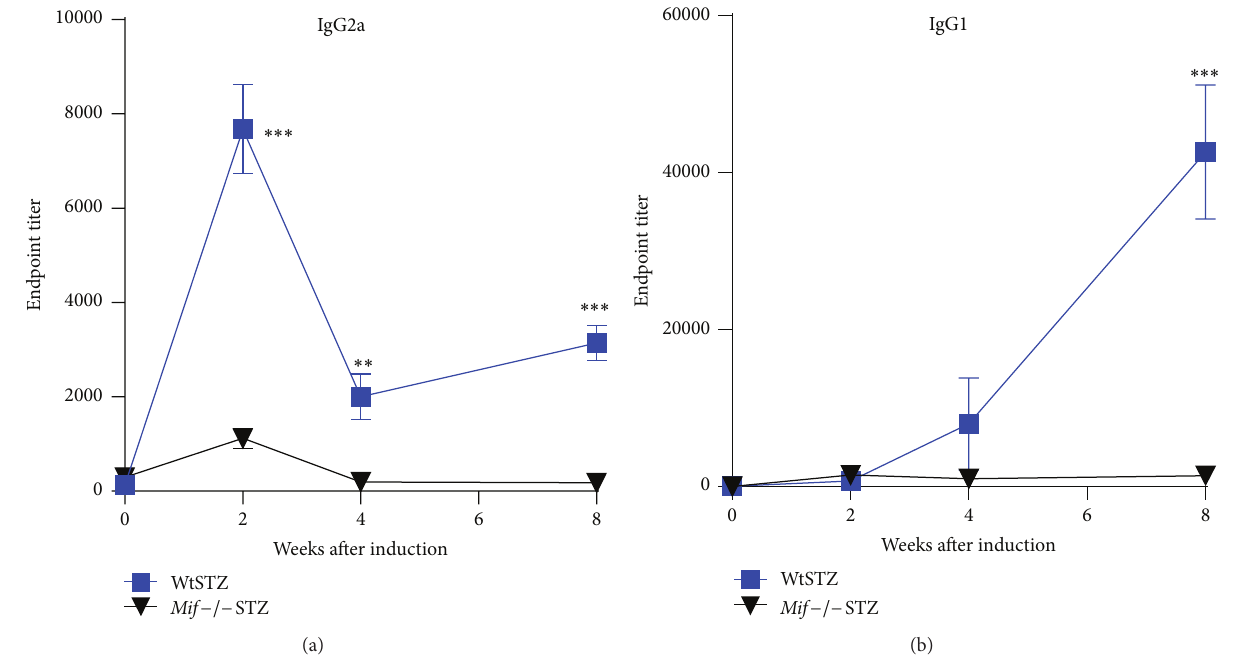
Figure 4: Kinetics of antibody responses in type 1 diabetes mellitus models induced by low-dose STZ. Specific production of IgG2a (a) and IgG1 (b) antipancreatic islet antigen antibodies. Sera from Wt ( ◼ ) and Mif − / − mice ( 󳶃 ) at weeks 0, 2, 4, and 8 after STZ administration were processed by ELISA, using pancreatic islets antigen (PIAg) as the source of specific antigen as indicated in Section 2. Data are expressed as the mean reciprocal endpoint titer ± SEM. Five to six animals were analyzed in each group. The data shown are representative of one out of three identical experiments with similar results. Mann-Whitney U test. ∗∗ 𝑝 < 0.01 , ∗∗∗ 𝑝 < 0.001 , GraphPad Prism software